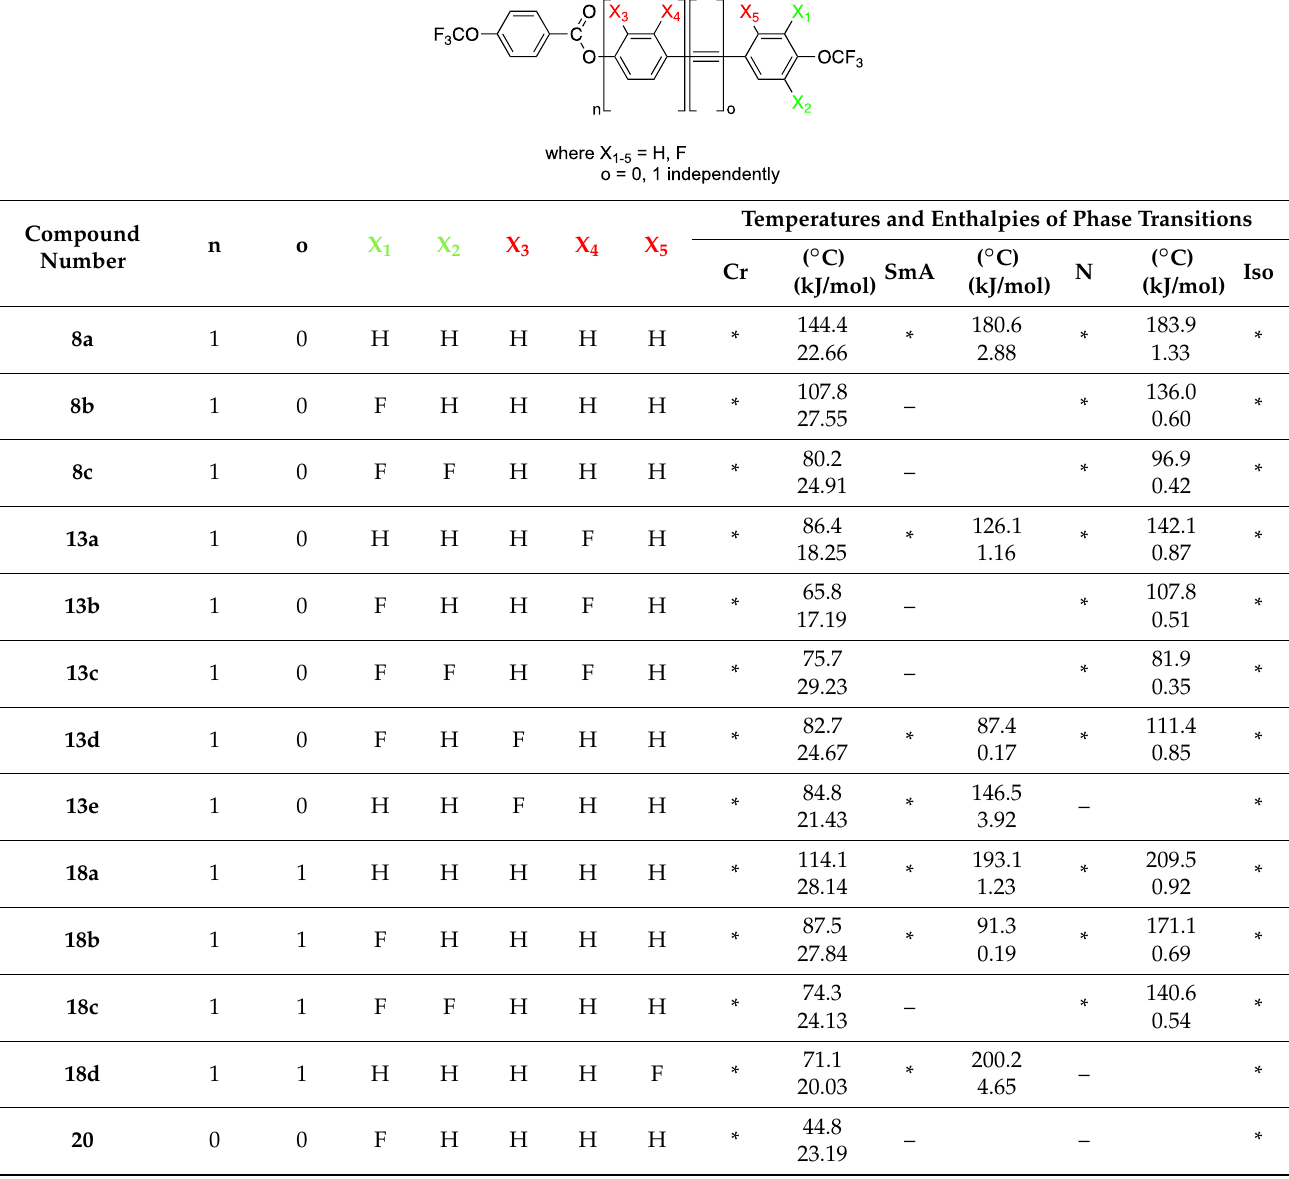
Table 1. Temperatures and enthalpies of phase transitions for synthesized compounds.